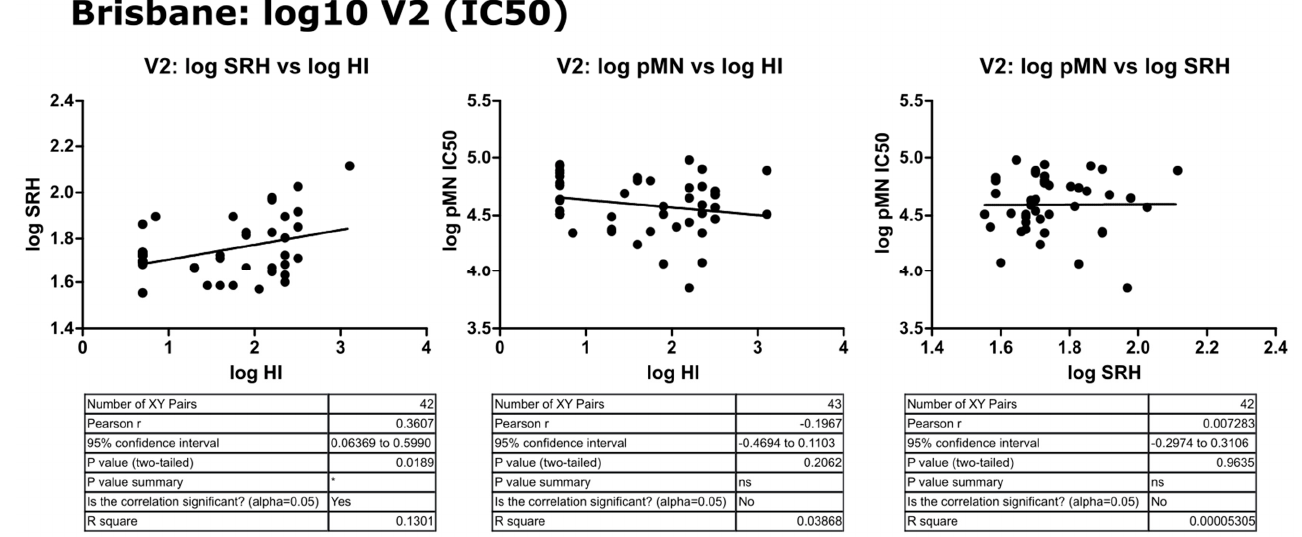
Figure 8. Correlation of transformed (log10) SRH, HI and pMN (IC 50 ) mean V2 values assayed against B/Brisbane/60/2008 PV. Pearson’s two-tailed analysis performed using GraphPad Prism. Weak correlation was observed between log SRH and HI values (Pearsons r = 0.36). No correlation was observed between log IC 50 antibody titres and log HI or SRH values (Pearsons r = − 0.196 and 0.007, respectively). p > 0.05 = ns, p ≤ 0.05 = *. Vaccines 2021 , 9 , x FOR PEER REVIEW